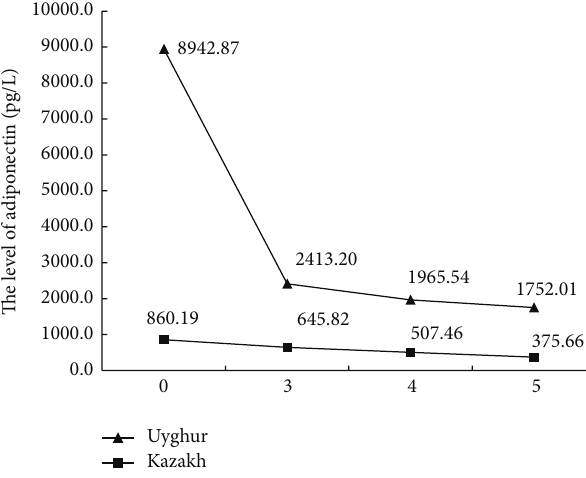
Figure 3: Comparing FFA with MS components.